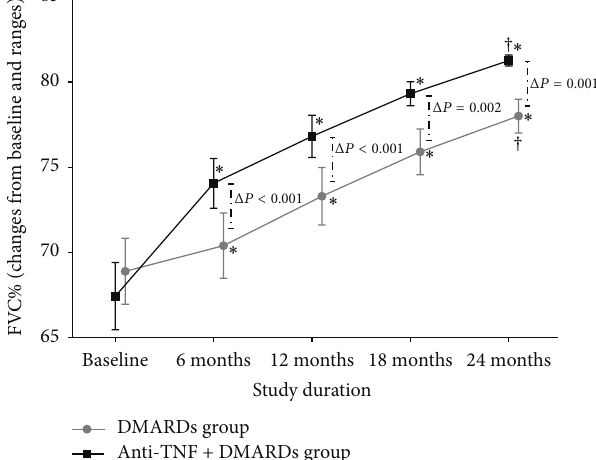
test; SGRQ, St. George’s Respiratory Questionnaire. Quantitative variables are presented as medians (and ranges); qualitative variables are presented in number (%). 𝑃 values were obtained using Wilcoxon test comparing responses at 12 and 24 months with the baseline. ∗ Significant difference with two-factor ANOVA Friedman test 𝑃 < 0.001 .